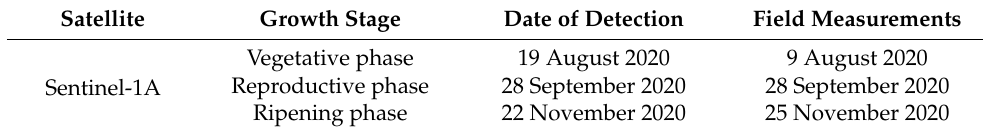
Table 1. Date of data acquisition at different growth stages.